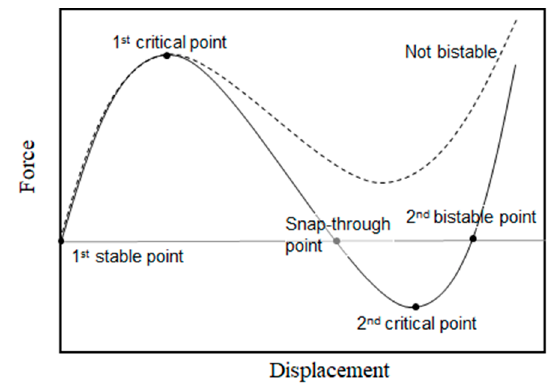
Figure 2. Force-displacement relation of a V-beam structure.